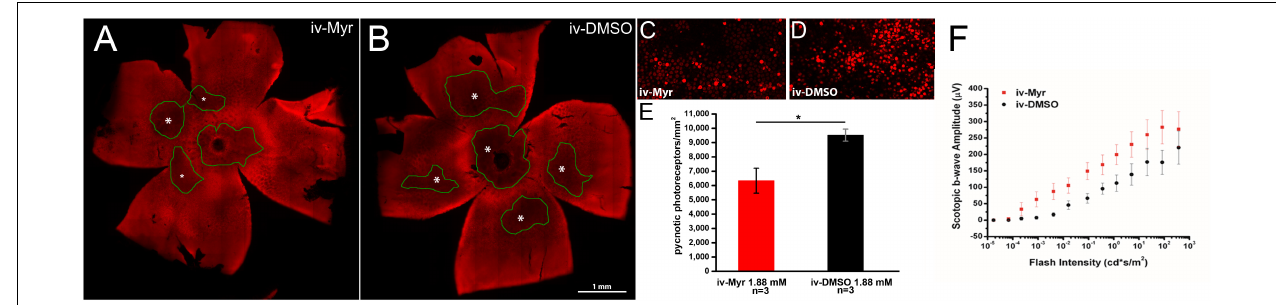
FIGURE 1 | Myriocin intravitreal injections in Tvrm4 mice. (A,B) Montages of images of whole-mount retinas stained with ethidium nuclear dye (red fluorescence). The focal plane is on the outer nuclear layer (ONL). Darker zones (green-encircled) indicate areas where photoreceptors have degenerated and their nuclei are missing. Larger degenerating zones are labeled with larger asterisks (*). The Myriocin-injected side shows dark zones that are visibly smaller (labeled with smaller asterisks) and less numerous compared to the control. (C,D) High magnification of the ONL of retinal whole mounts as those shown in A and B. Bright red nuclei belong to photoreceptors that entered in a stage of DNA condensation (pyknotic nuclei), visibly less numerous in the Myriocin-injected compared to the control eye. Imaged fields have consistent eccentricity and have been acquired with identical confocal microscope settings. (E) In the underlying bar graph, the average number of pyknotic nuclei is compared in retinas treated with Myriocin (red bars) and retinas treated with vehicle (black bars). Measurements are from three different mice ( n = 3). (F) Sensitivity curve of the scotopic b-wave amplitude in Myriocin-treated (red squares) and vehicle-treated eyes (black circles) ( n = 3). Bar values represent mean ±